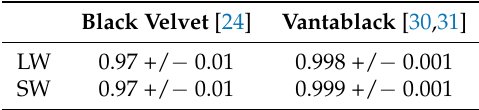
Table 1. Spectral absorbance and uncertainty of Black Velvet and Vantablack. For perpendicular illumination, the absorbance values for LW and SW are equal within the